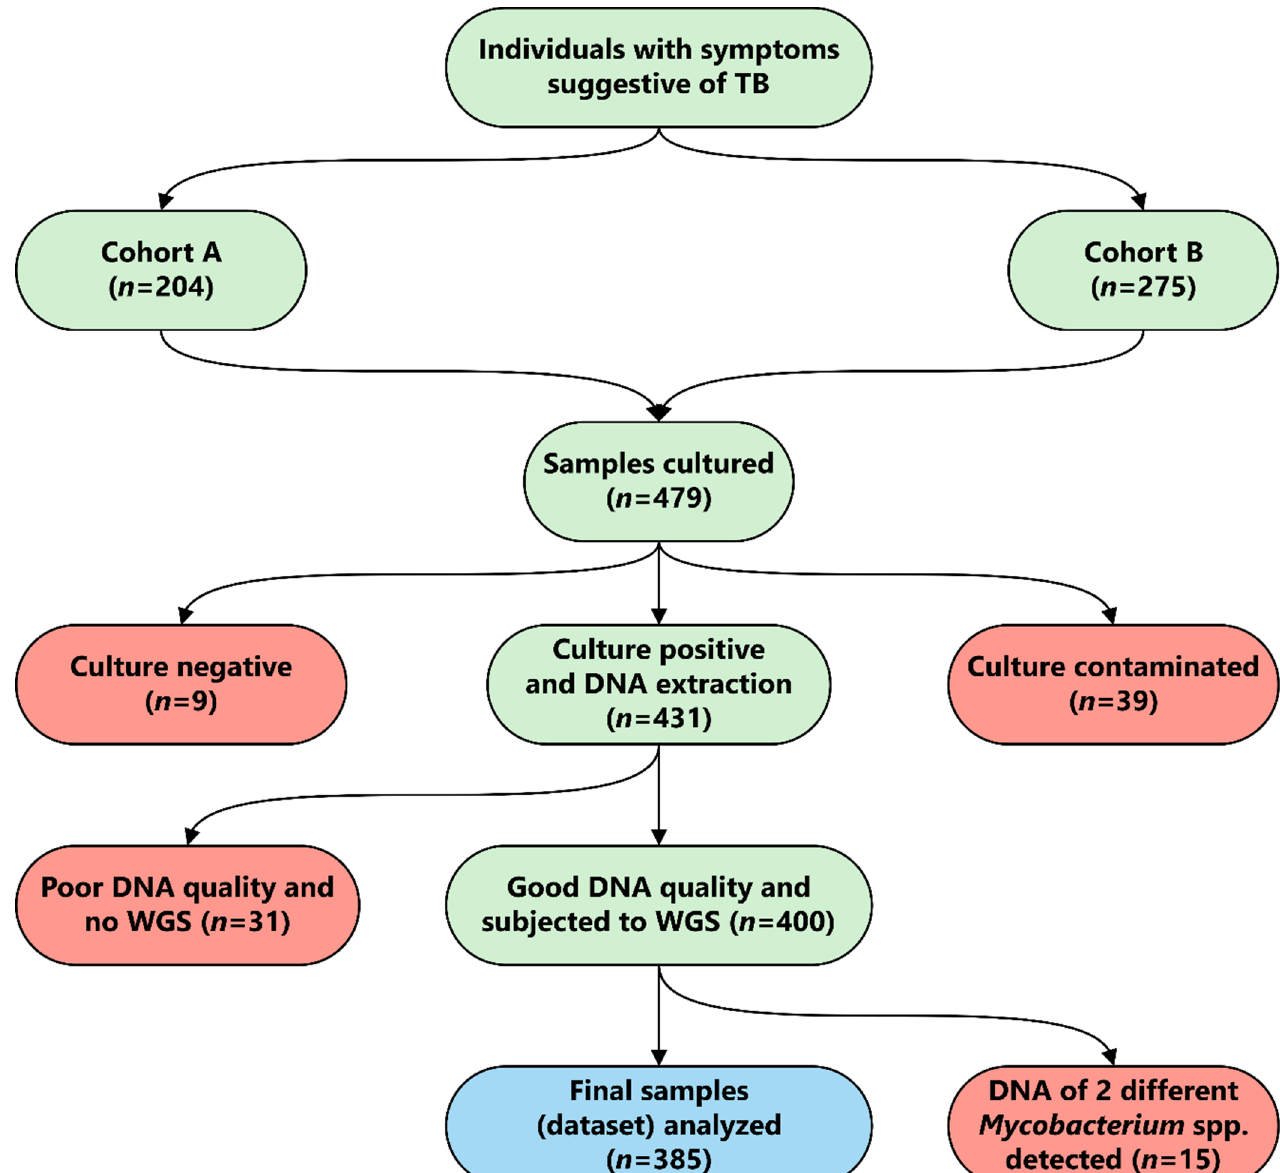
Figure 1. Workflow for the study “Molecular epidemiology of Mycobacterium tuberculosis complex strains in urban and slum settings of Nairobi, Kenya”. TB = tuberculosis, Cohort A = patients en- rolled in 2010, Cohort B = patients enrolled in 2014–2015, WGS = whole-genome sequencing, spp. = species.